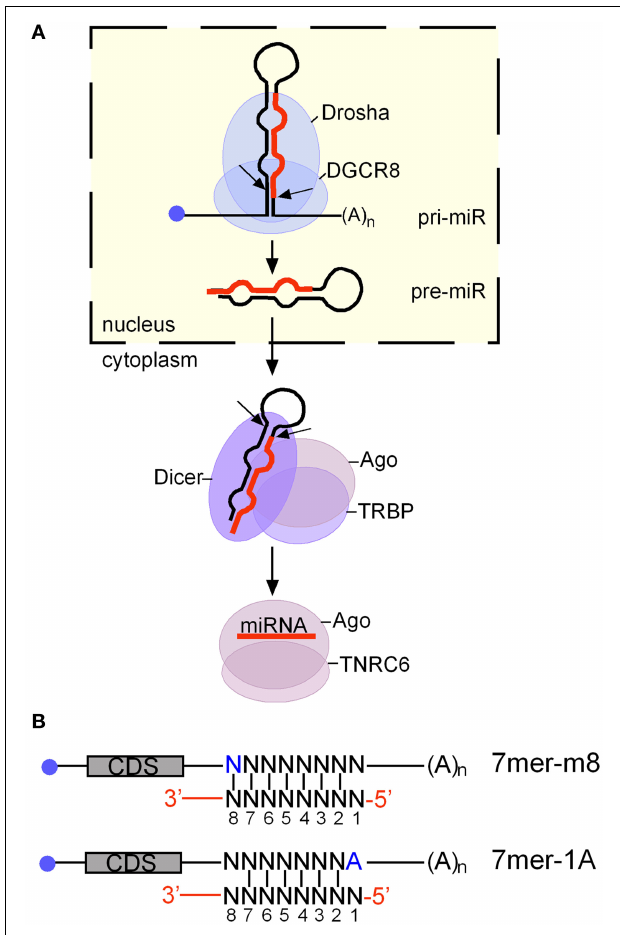
FIGURE 1 | miRNA biogenesis and target recognition. (A) Schematic of the canonical miRNA biogenesis pathway. pri-miRNAs are typically capped and polyadenylated and contain one or more miRNA stem-loops at exonic or intronic locations.The pre-miRNA stem-loop is excised by the microprocessor complex, containing the endonuclease Drosha and its cofactor DiGeorge syndrome critical region gene 8 (DGCR8), which helps position Drosha. Following nuclear export, the pre-miRNA is processed by Dicer to a miRNA:passenger strand duplex. Dicer processing is closely coupled to loading of the mature miRNA into the RISC. RISC complexes contain one of four Ago proteins (Ago1–4), which bind the miRNA, and associated proteins, includingTNRC6. (A) n indicates the position of the polyA tail and arrows indicate cleavage sites. (B) Shown are the minimal 7mer-m8 (top) and 7mer-1A (bottom) seed-mediated interactions between a miRNA (nts are numbered from the 5 (cid:2) end of the miRNA) and its mRNA